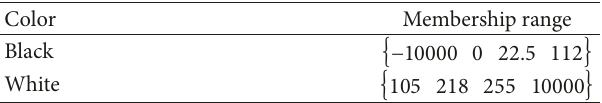
Table 3: Final membership functions for inputs.